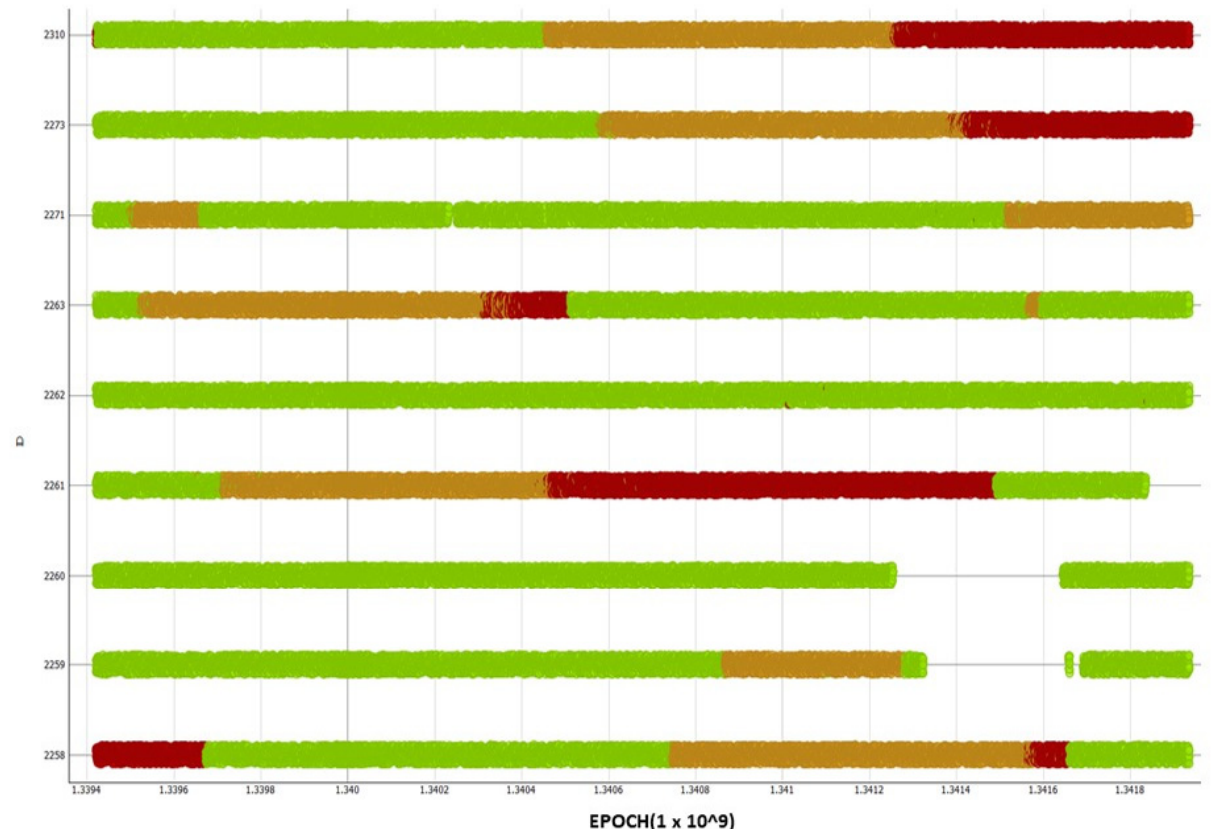
Figure 9. Time series data for various terminal IDs vs. time. Green sections are normal working conditions, amber sections are cloud cover, and red is either disruption or heavy cloud cover affecting signal quality, e.g.,